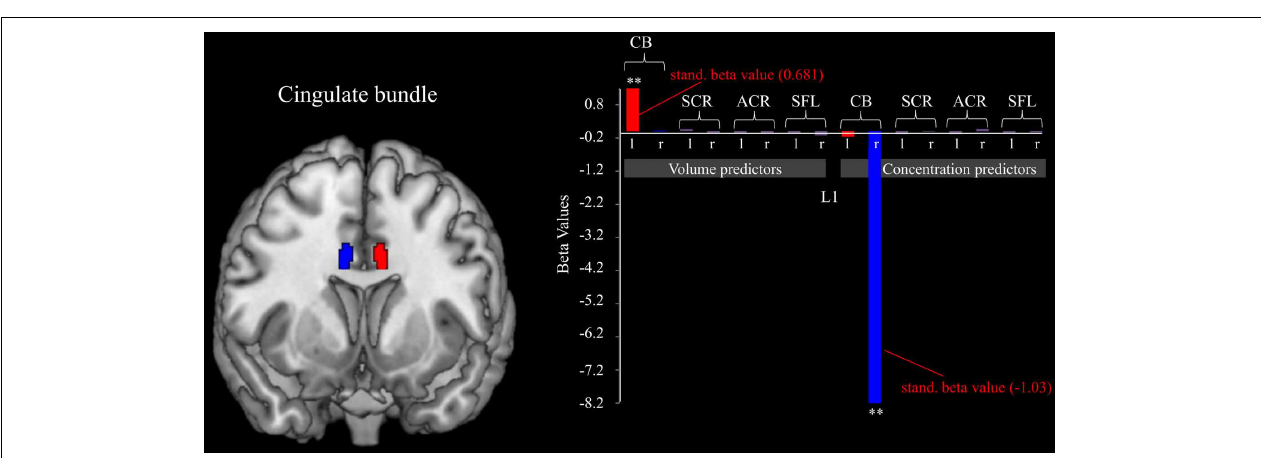
FIGURE 3 | Cingulate bundle morphology predicts L1. The figure shows the relation between the volumes and concentrations of white matter belonging to different brain tracts and the fm-theta increases during training sessions (indexed by L1). The volume of the left, and the concentration of the